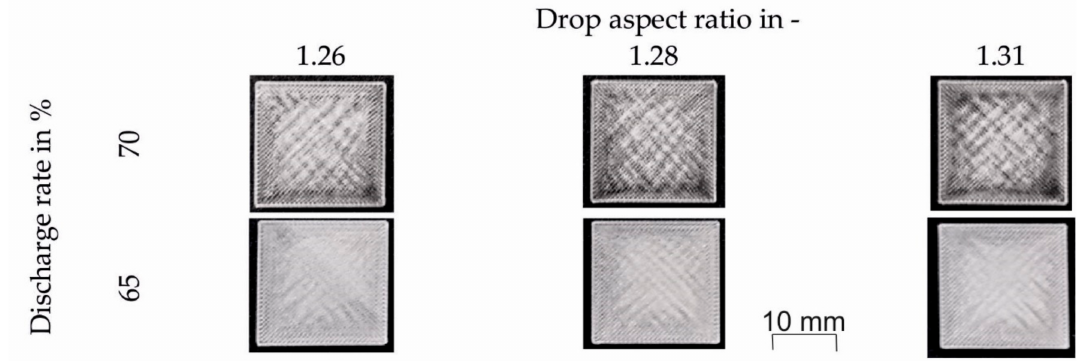
Figure 4. Cubic specimens printed at a chamber temperature of 100 ◦ C with three di ff erent drop aspect ratios (1.26, 1.28, and 1.31) and discharge rates of 70 and 65%. Other processing temperatures were T 1 = 195 ◦ C, T 2 = 225 ◦ C, and T nozzle = 240 ◦